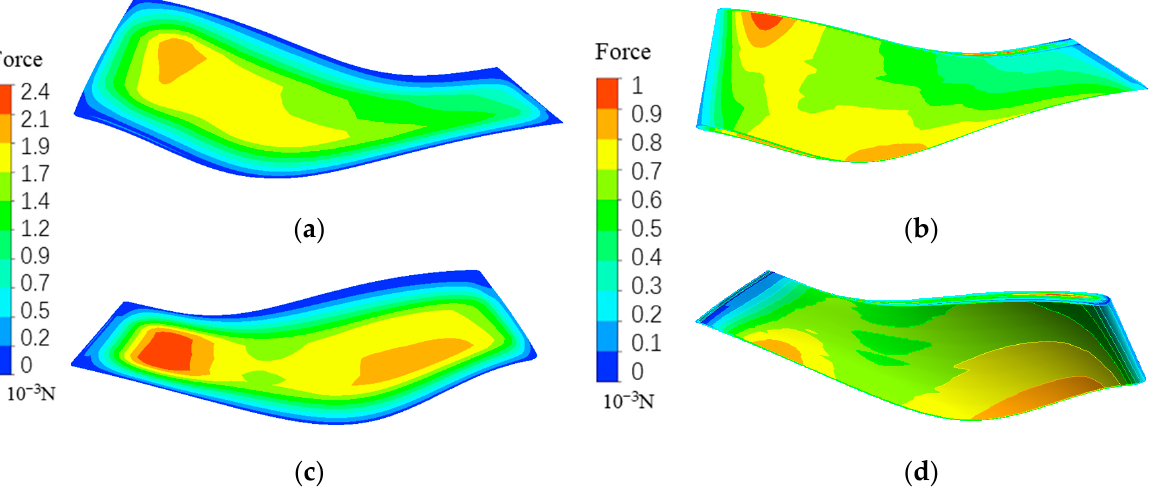
Figure 7. Blade force distribution ( a ) optimize blade pressure surface; ( b ) original blade pressure surface; ( c ) optimize blade suction surface; ( d ) original blade suction surface.